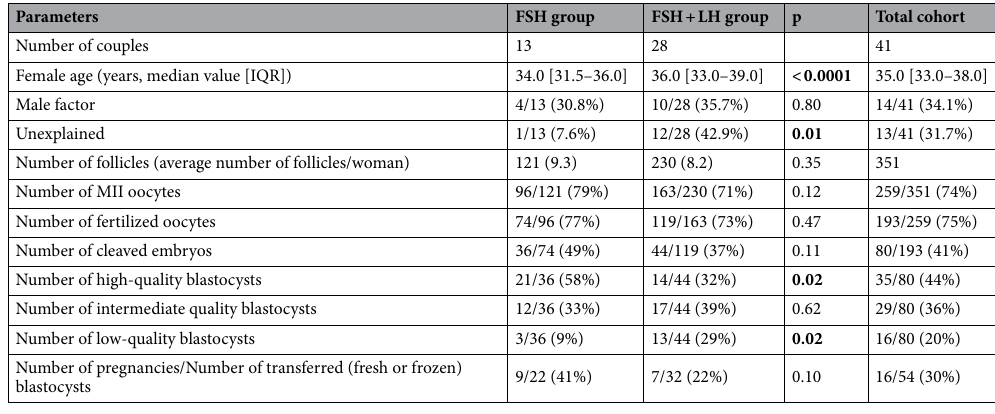
Table 1. Baseline characteristics of the participating couples in the two groups of ovarian stimulation (FSH and FSH + LH) and in the total cohort. p column indicates the statistical significance between the two groups of ovarian stimulation. In bold statistically significant